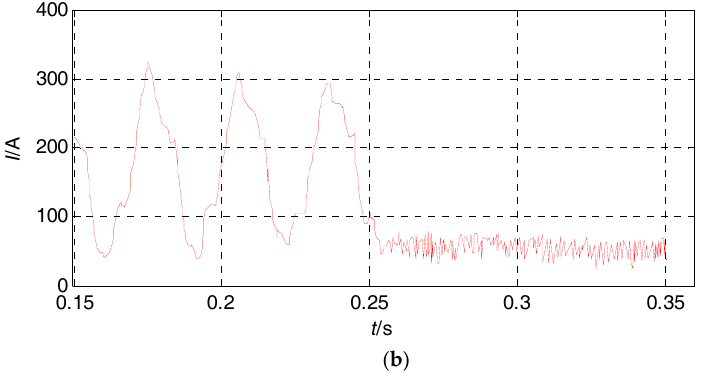
Figure 7. The simulation results of circulation current: ( a ) M 2 PC; ( b ) Improved multi ‐ step M 2 PC.